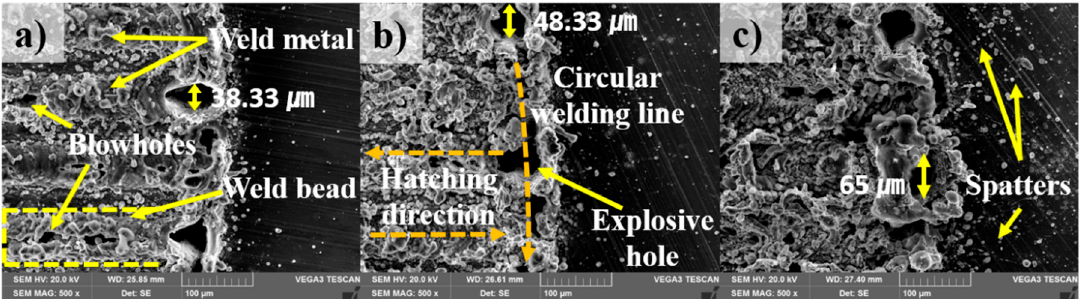
Figure 3. SEM images of the top view ( a ) 10 W, ( b ) 15 W and ( c ) 20 W.